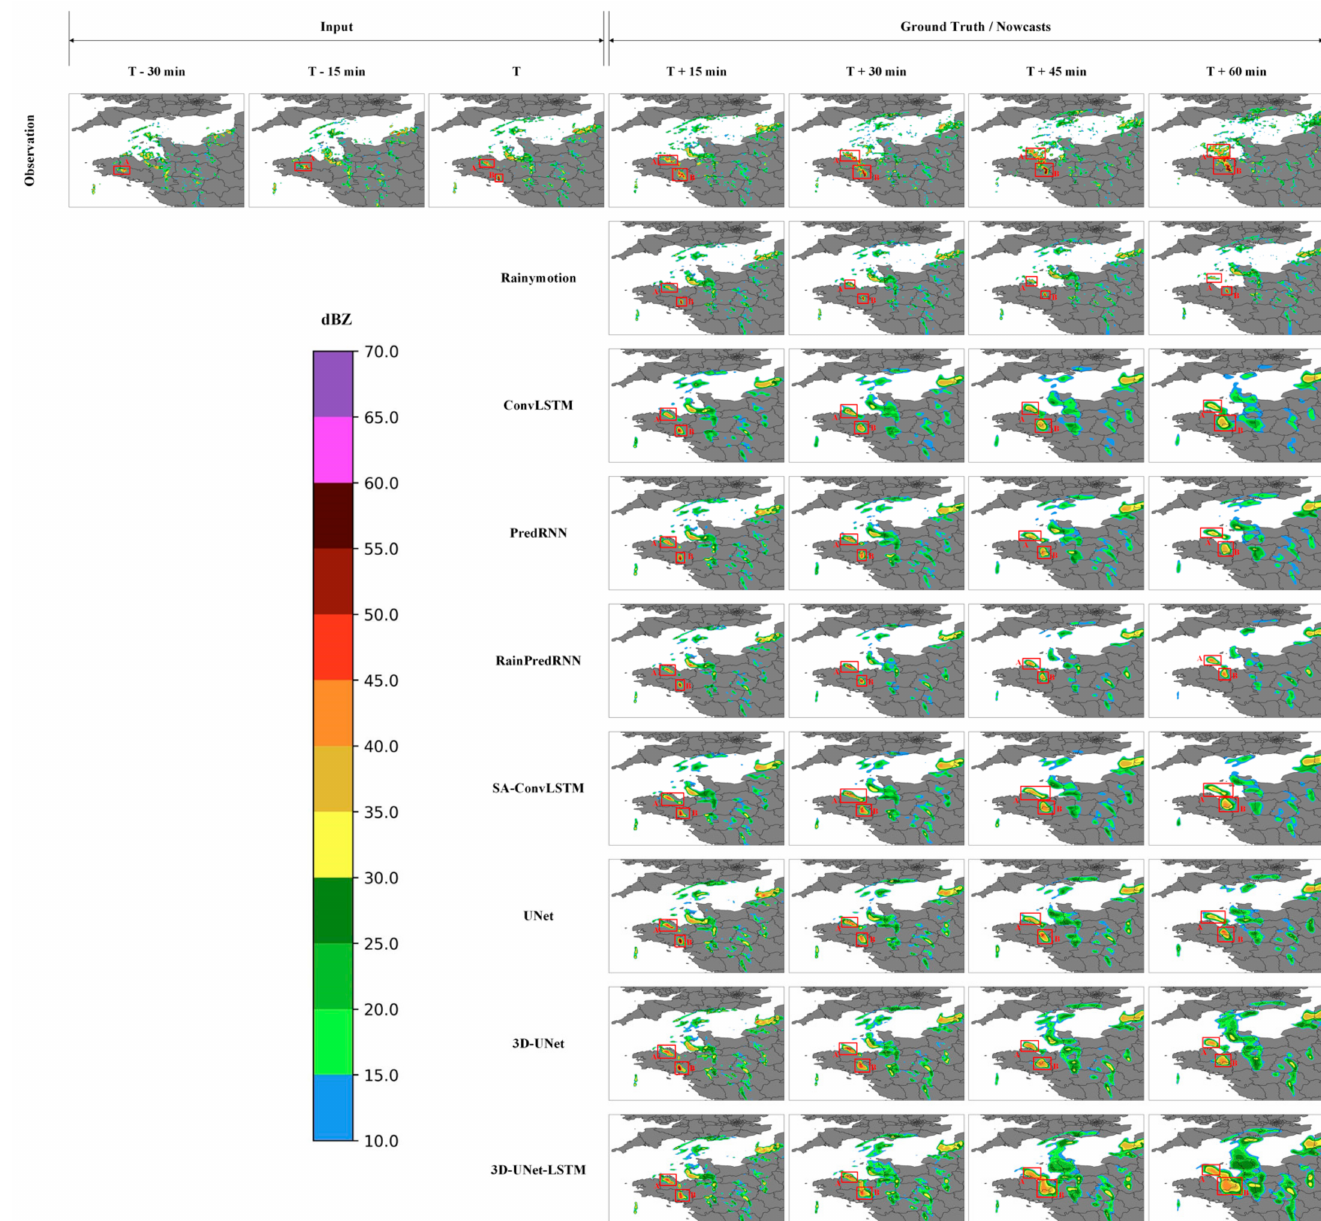
Figure 5. A representative case of local strong convective growth in the northwestern quarter of France at a forecasting time of T = 7 August 2018, 11:55 UTC. Letters A–B represents different regions where the proposed 3D-UNet-LSTM performs